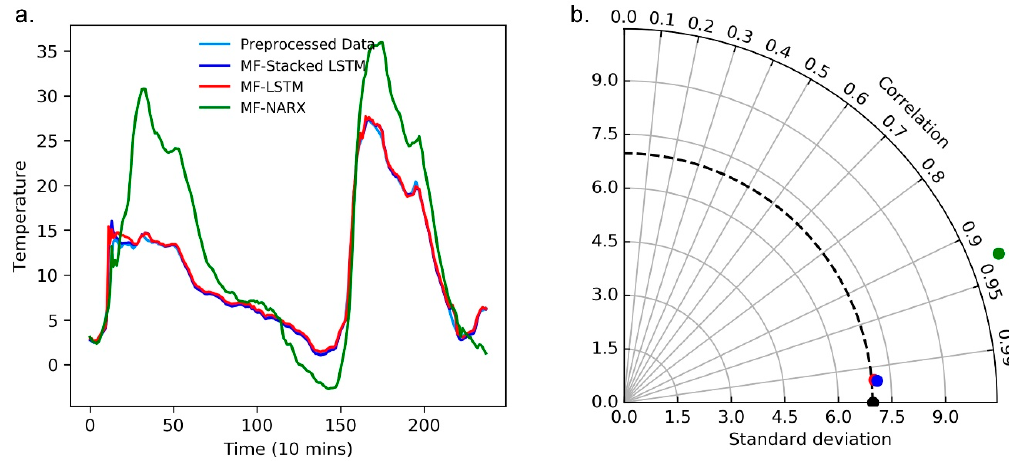
Figure 7. Curve diagram and Taylor diagram of the predictors with the median filter (MF) for the panel temperature. ( a ) The curve diagram of the predictors; ( b ) The Taylor diagram of the predictors.